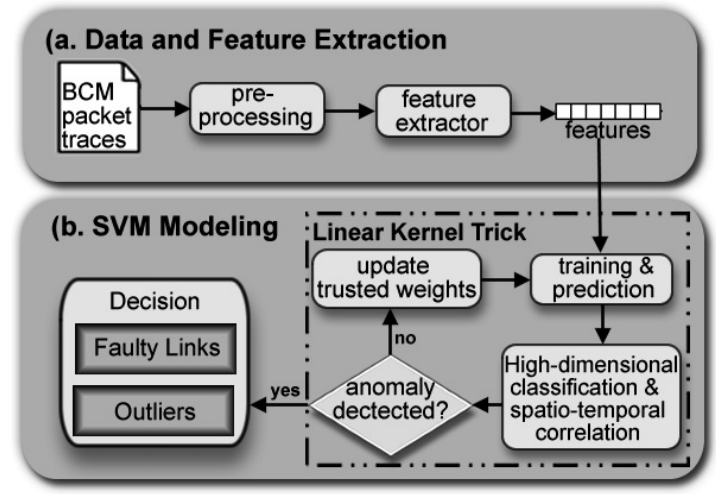
Figure 1. Kernelized Linear Support Vector Machine (KLSVM) Model: the Data-driven framework for reliable link